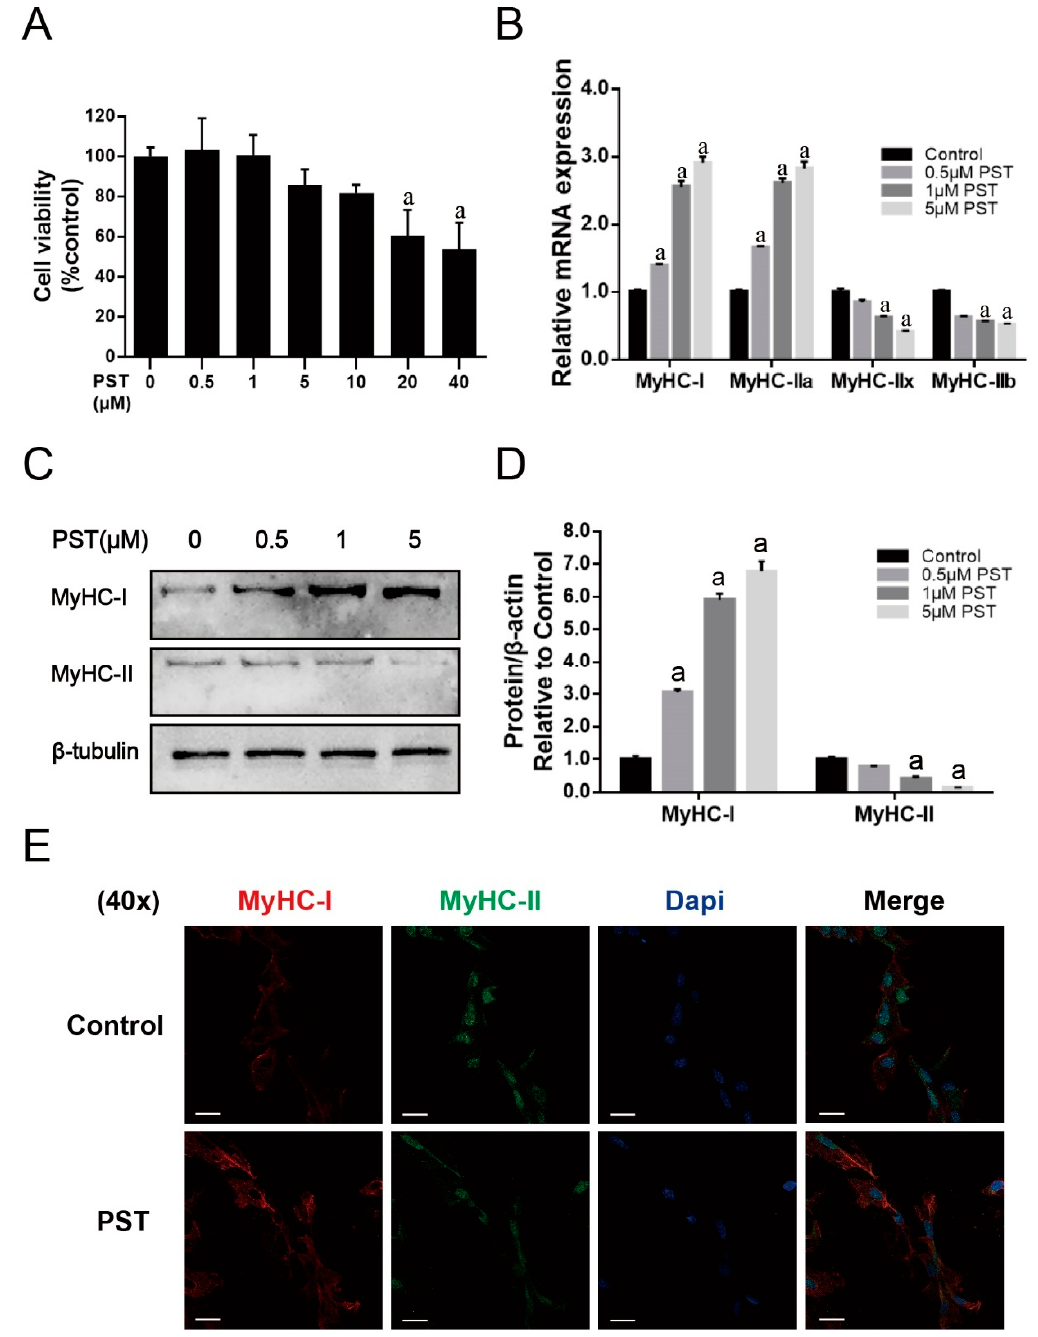
Figure 4. Effects of pterostilbene (PST) treatment on muscle fiber types in C2C12 myotubes. Cell viability ( A ) was measured using a CCK-8 assay. Gene expressions of MyHC-I, MyHC-IIa, MyHC-IIx, and MyHC-IIb ( B ). Representative images of western blots of genes related to muscle fiber type transition ( C ) and their quantitative analysis ( D ) in C2C12 myotubes treated without or with 0.1–5 µ M PST. Representative immunofluorescence images of C2C12 myotubes treated without or with 1 µ M PST ( E ). The cells were labeled with primary antibody for MyHC-I (red) and MyHC-II (green), as well as with DAPI (blue). Scale bar, 20 µ m. Protein expression levels were normalized to the expression of β -tubulin. Data are expressed as mean ± SD, a— p < 0.05 compared with the control group.